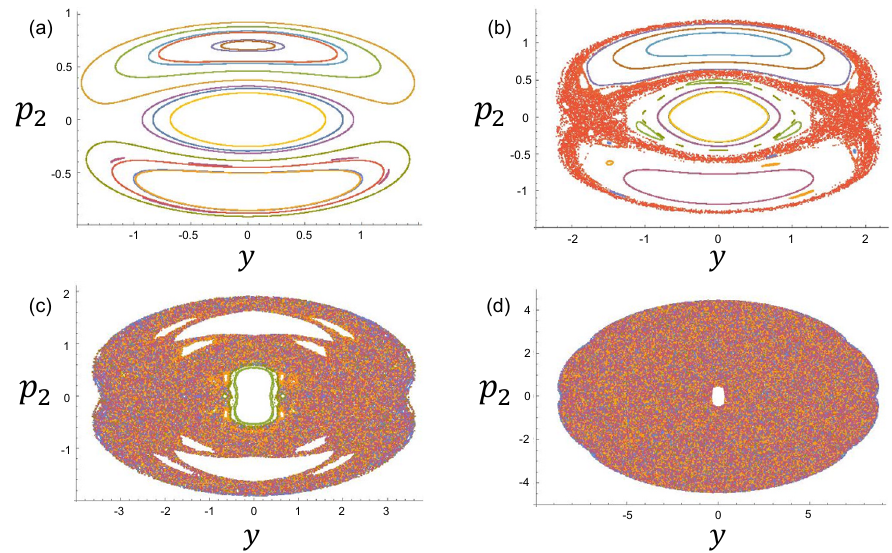
Figure 1 . Poincar(cid:19)e sections of the CHO Hamiltonian system. (a) E = 1: the orbits are periodic and the system is integrable. (b) E = 2: scattering has begun and the chaos is appearing. (c) E = 4: although much scattered, some periodic orbits can be seen. (d) E = 20: almost everywhere scattered, the system is chaotic enough. Points are sampled when the trajectory crosses x = 0 with p x > 0. 46], we plot in (cid:12)gure 1 the Poincar(cid:19)e sections at several chosen values of the energy. In the (cid:12)gure, sub(cid:12)gure (a), (b), (c) and (d) correspond to E = 1 ; 2 ; 4 and 20 respectively. At